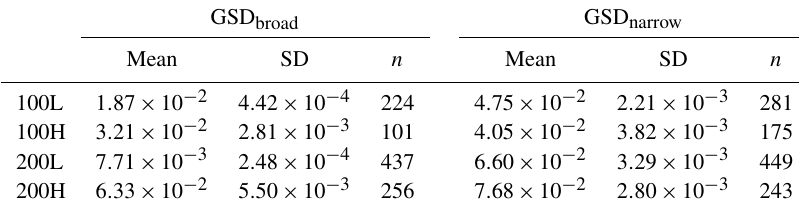
Table 6. Mean transport efficiencies and their standard deviation with the number of observations ( n ) of the experiments.